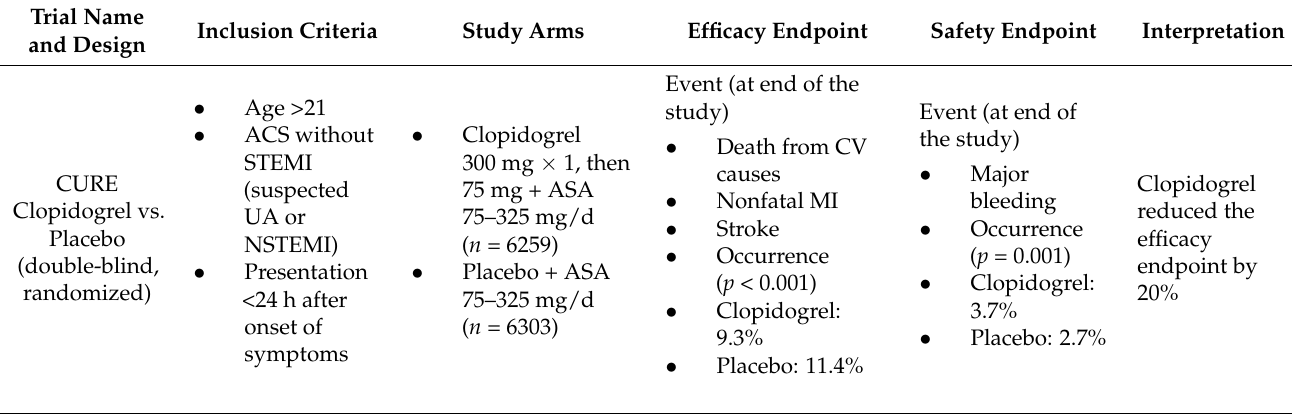
Table 1. Comparison of RCTs for oral P2y12 Inhibitors